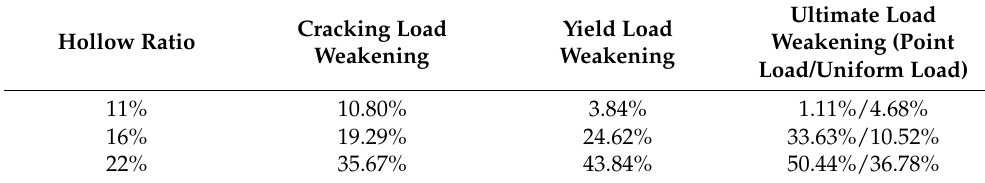
Table 3. Test load Table 3. Test load results.